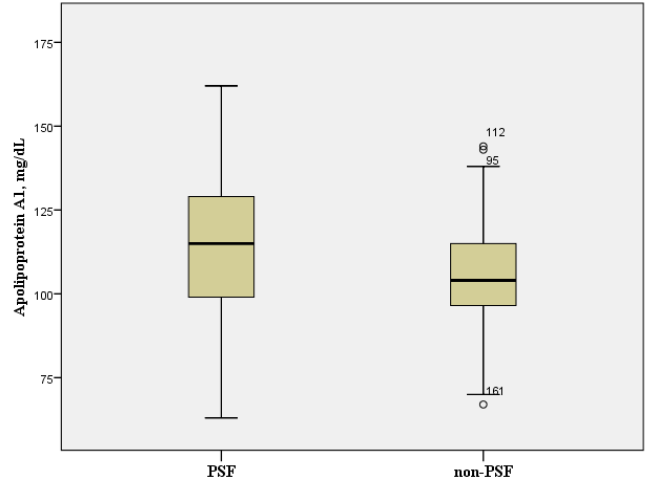
Figure 2. Box plot of apolipoprotein A1. PSF group: patients with post-stroke fatigue. Non-PSF group: patients without post-stroke fatigue.